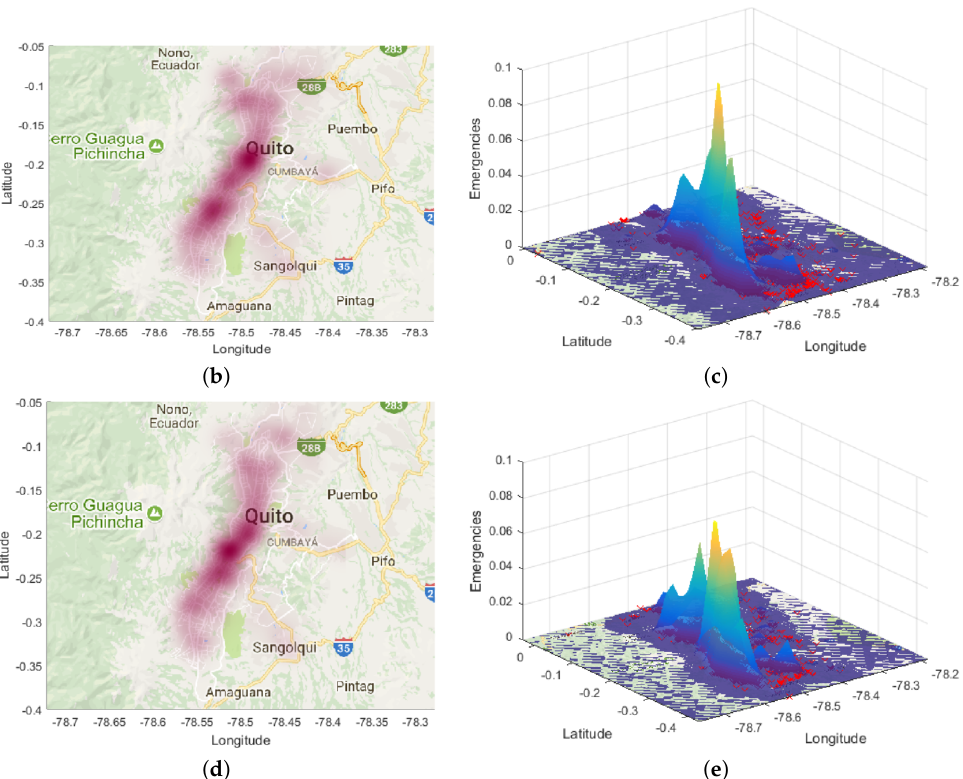
Figure 10. Analysis of police emergencies. ( a ) Events during 2014, with maximum and minimum peaks; ( b , c ) Parzen distribution in red gradient over the map and bidimensional probability density function (PDF) representation for maximum peak on December 6; ( d , e ) The same for minimum peak on 2 January.